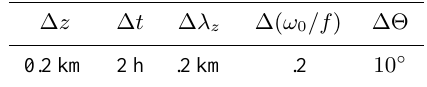
Table 2. Assumed uncertainties on the wave-packet characteristics ∆ z ∆ t